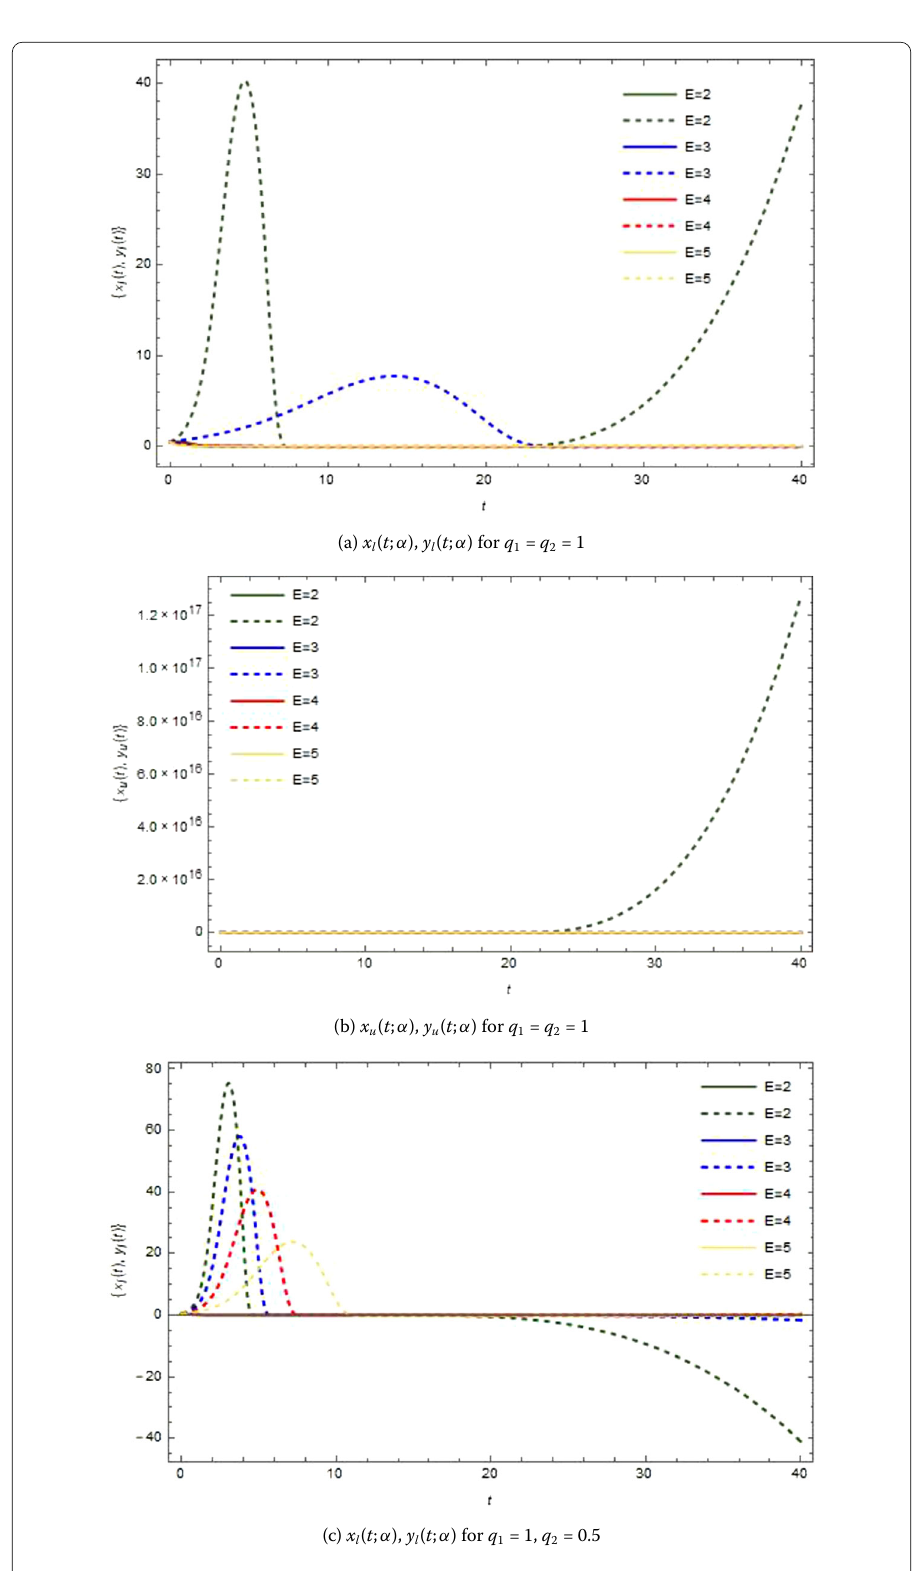
Figure 2 Solutions of system (12), straight lines for ˜ x ( t ) and dotted lines for ˜ y ( t ), for the cases q 1 = q 2 , q 1 > q 2 and q 1 < q 2 at α = 0.98, σ = 0.998 and for different values of